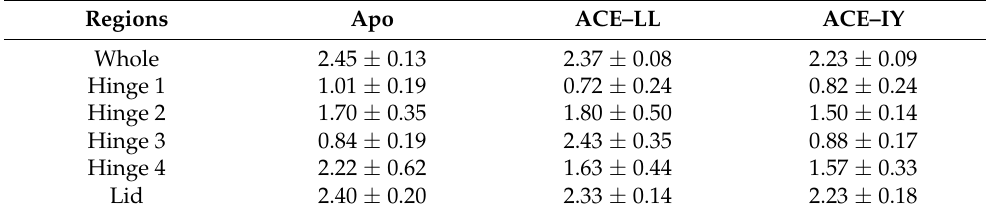
Figure 2. The temporal evolution of the RMSDs from their initial structure of three complexes in the region of ( a ) the whole protein, ( b ) hinge 1, ( c ) hinge 2, ( d ) hinge 3, ( e ) hinge 4 and ( f ) the lid. RMSD is root mean square deviation. Table 1. Average C α RMSD and standard deviations of the whole protein, hinge 1, hinge 2, hinge 3, hinge 4, and the lid during the GaMD simulations in Å.